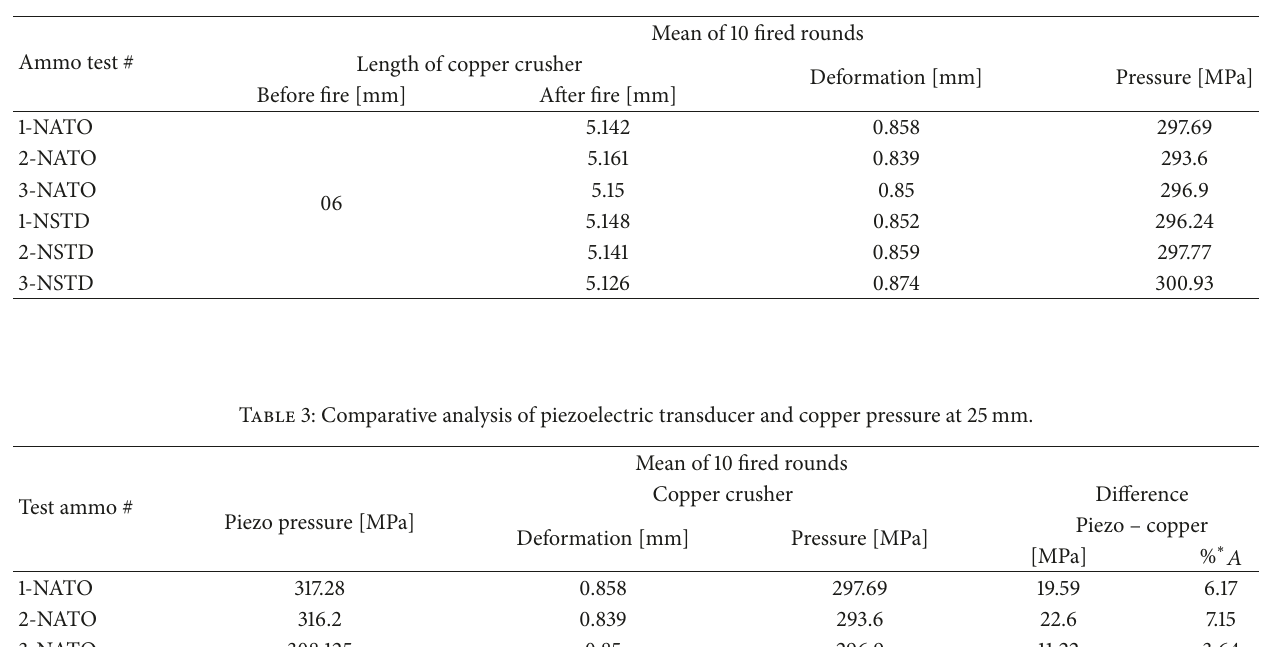
Table 2: Experimental analysis of pressure at 25 mm copper crushers test.